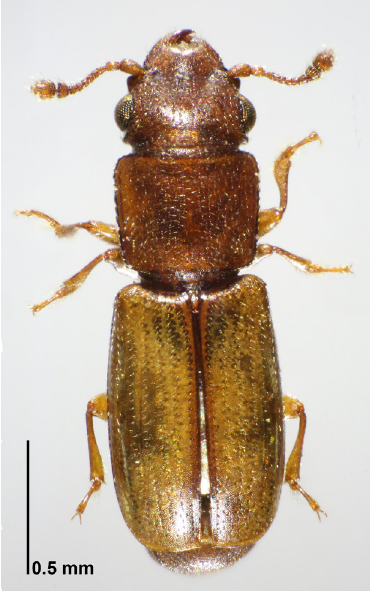
Figure 1. Adult Europs sp. (Order Coleoptera, Family